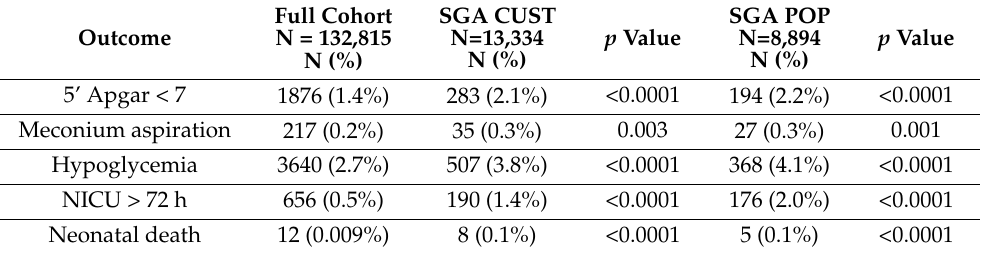
Table A2. Adverse neonatal outcomes by SGA groups.